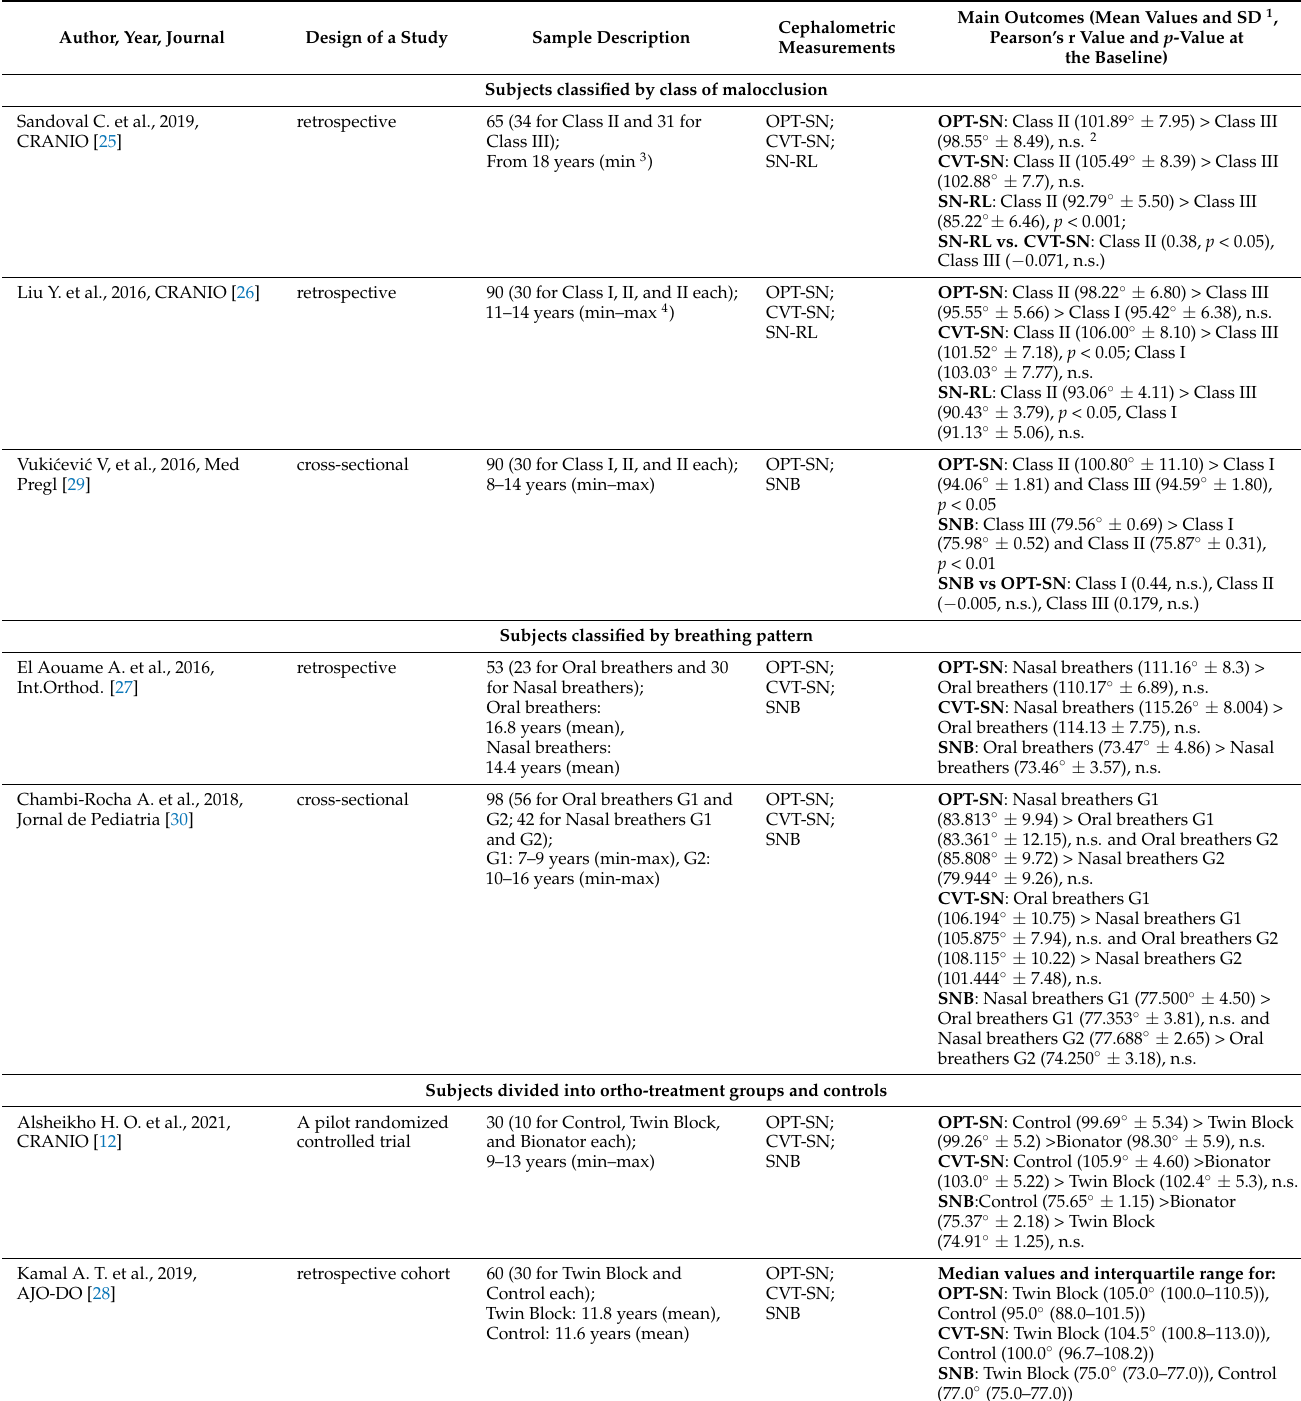
Table 4. A description of eligible